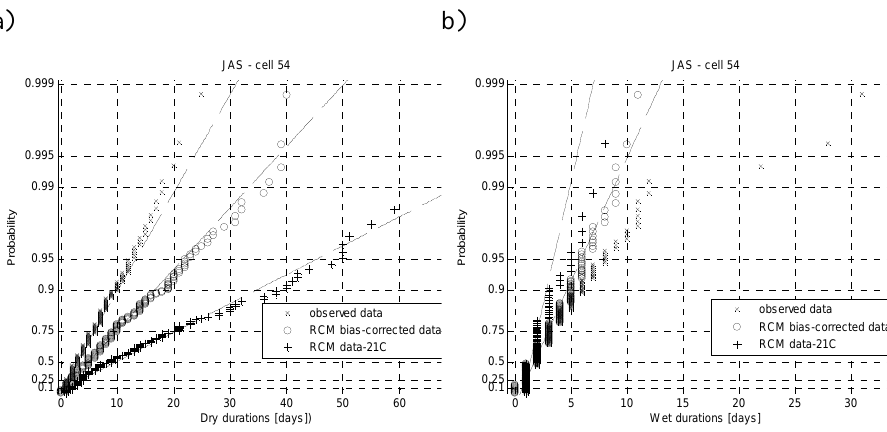
Figure 6. The distributional agreement of storm intensity is represented by the qq- Fig. 6. The distributional agreement of storm intensity is represented by the qq-plots between observations and RCM bias-corrected data corresponding to the calibration period (1961-1990) in the autumn season (a) , in the winter season (b) , in the spring season (c) , and in the plots between observations and RCM bias-corrected data corresponding to the summer season (d) . calibration period (1961-1990) in the autumn season (a), in the winter season (b), in the spring season (c), and in the summer season (d).